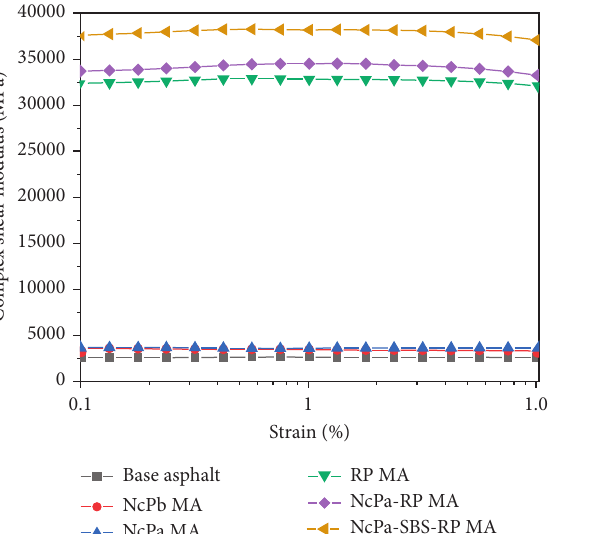
Figure 6: Complex shear modulus versus temperature.